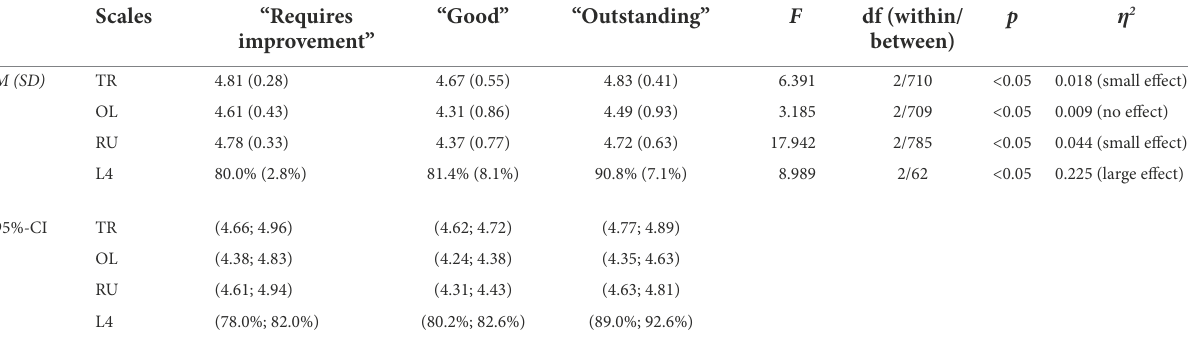
TABLE 5 Mean differences for trust, organizational learning, research use (individual level) and Level 4-results (school level). Scales “Requires “Good” improvement”